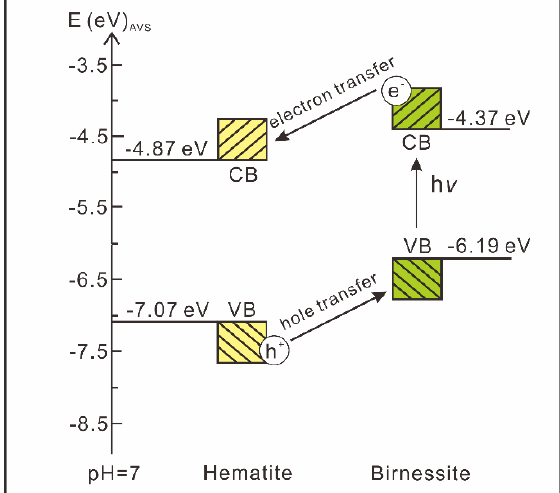
Figure 13. Scheme of the matched band structure of hematite and birnessite in the rock Fe / Mn coating.